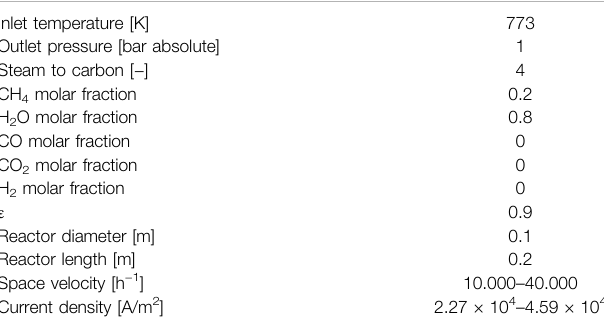
TABLE 5 | Operative conditions for simulations in section with Open cell foams a Non-Adiabatic e-MSR Unit . Inlet temperature